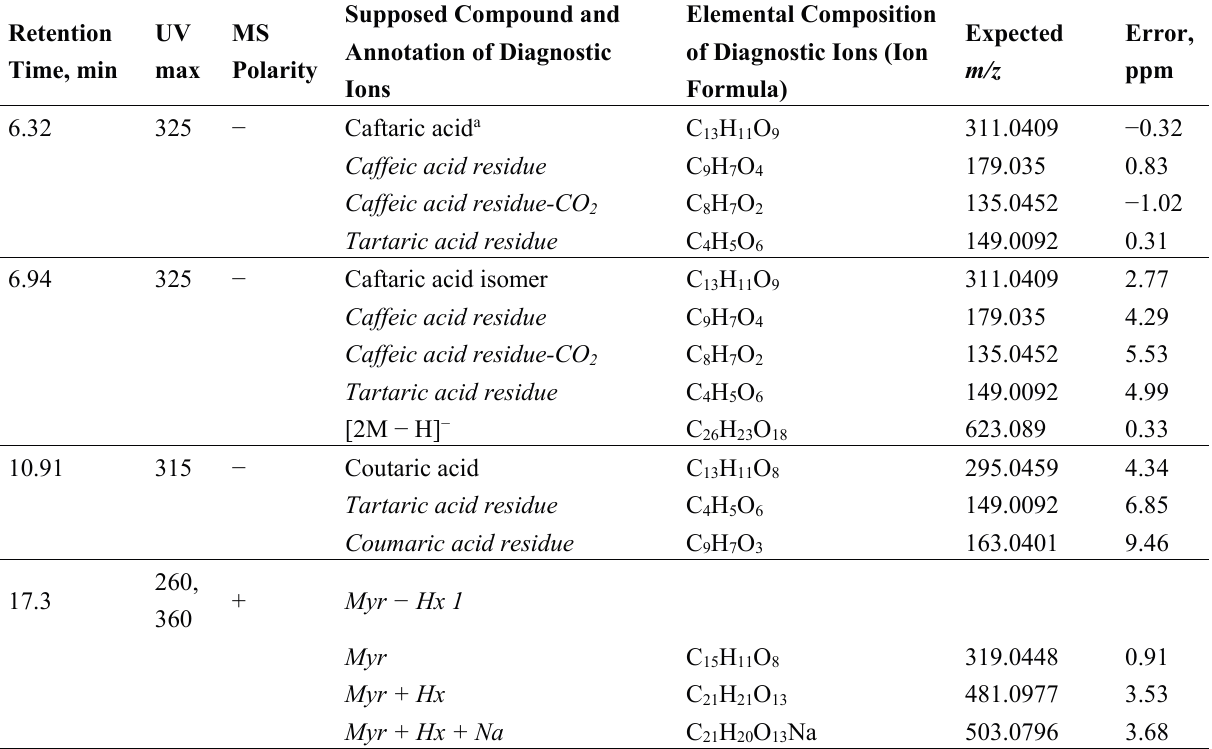
Table A1. Observed diagnostic ions of polyphenols found in the Gohér leaf